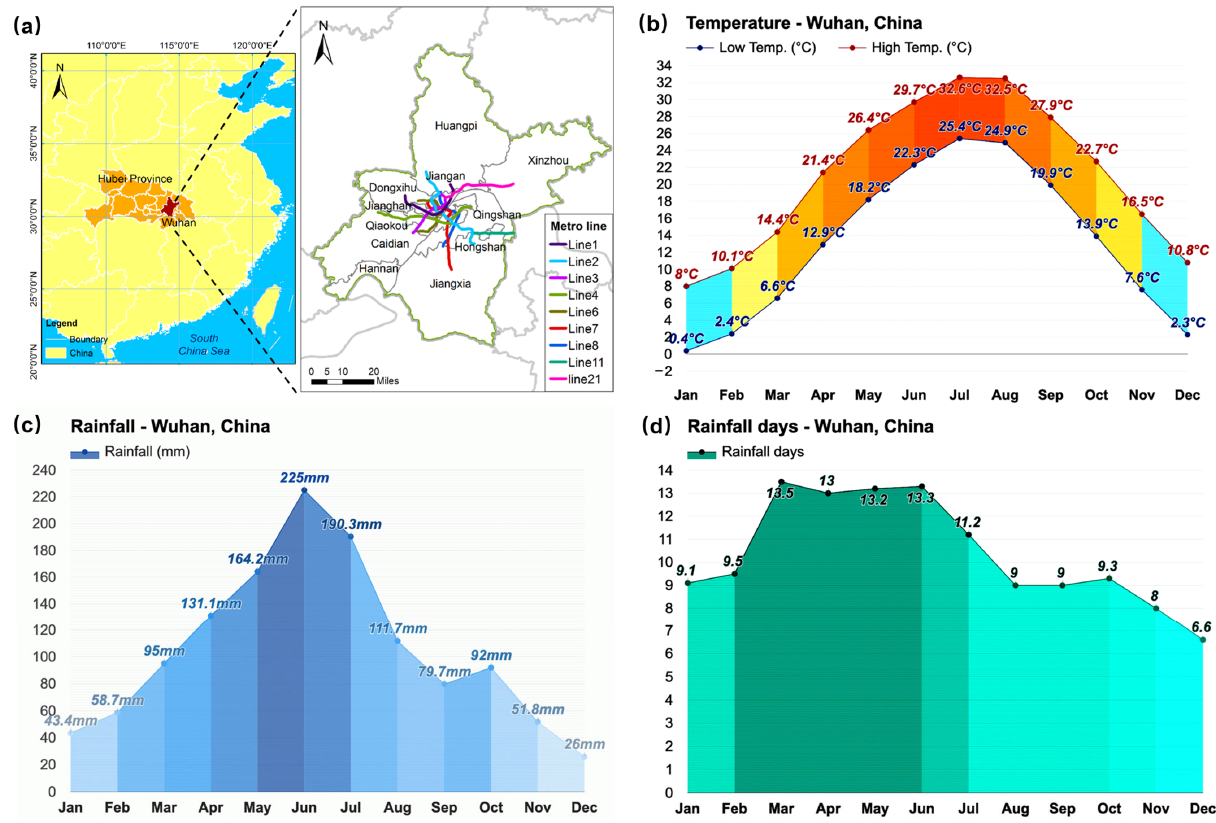
Figure 3. Climate and location information for Wuhan. ( a ) Administrative region of Wuhan with the metro system. ( b ) Temperature of Wuhan. ( c ) Rainfall. ( d ) Rainfall days.